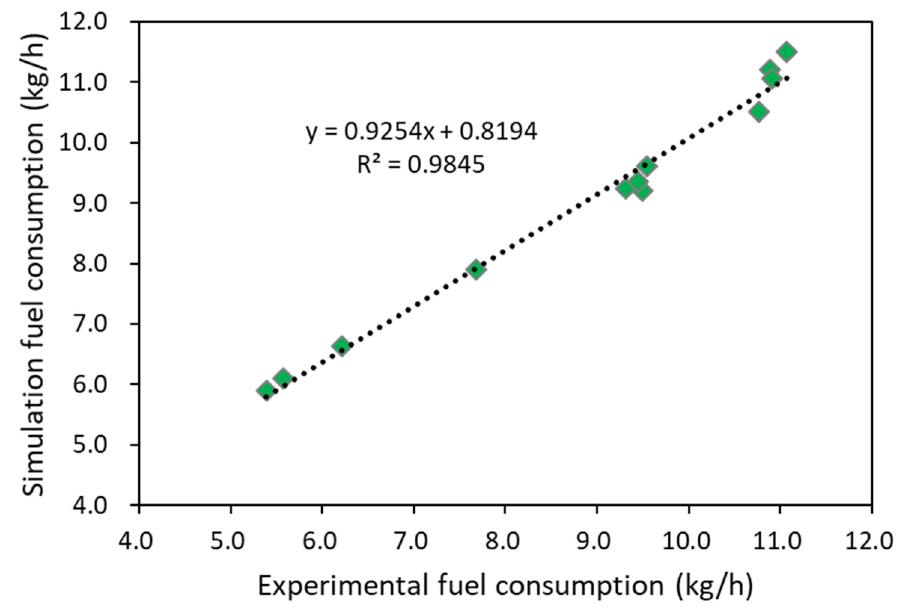
Figure 8. Regression analysis of fuel consumption during asphalt operation.